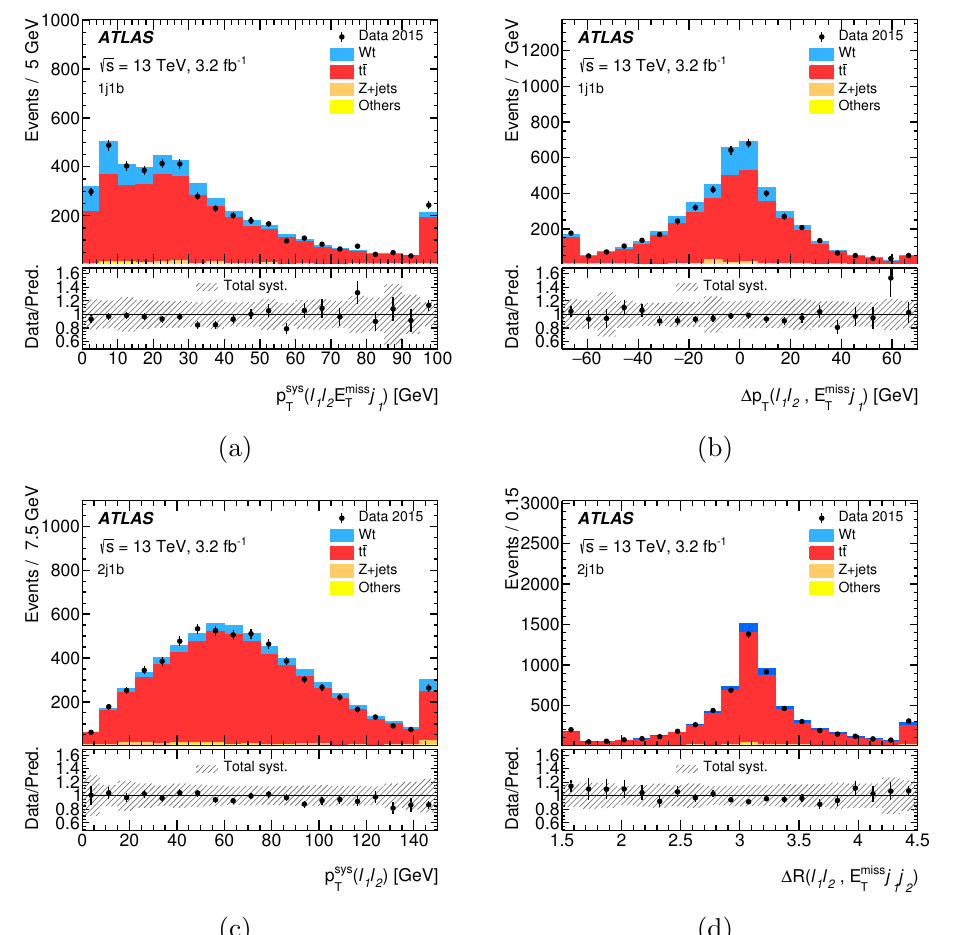
Figure 5. Distributions of the two most powerful BDT input variables in each (cid:12)t region: in